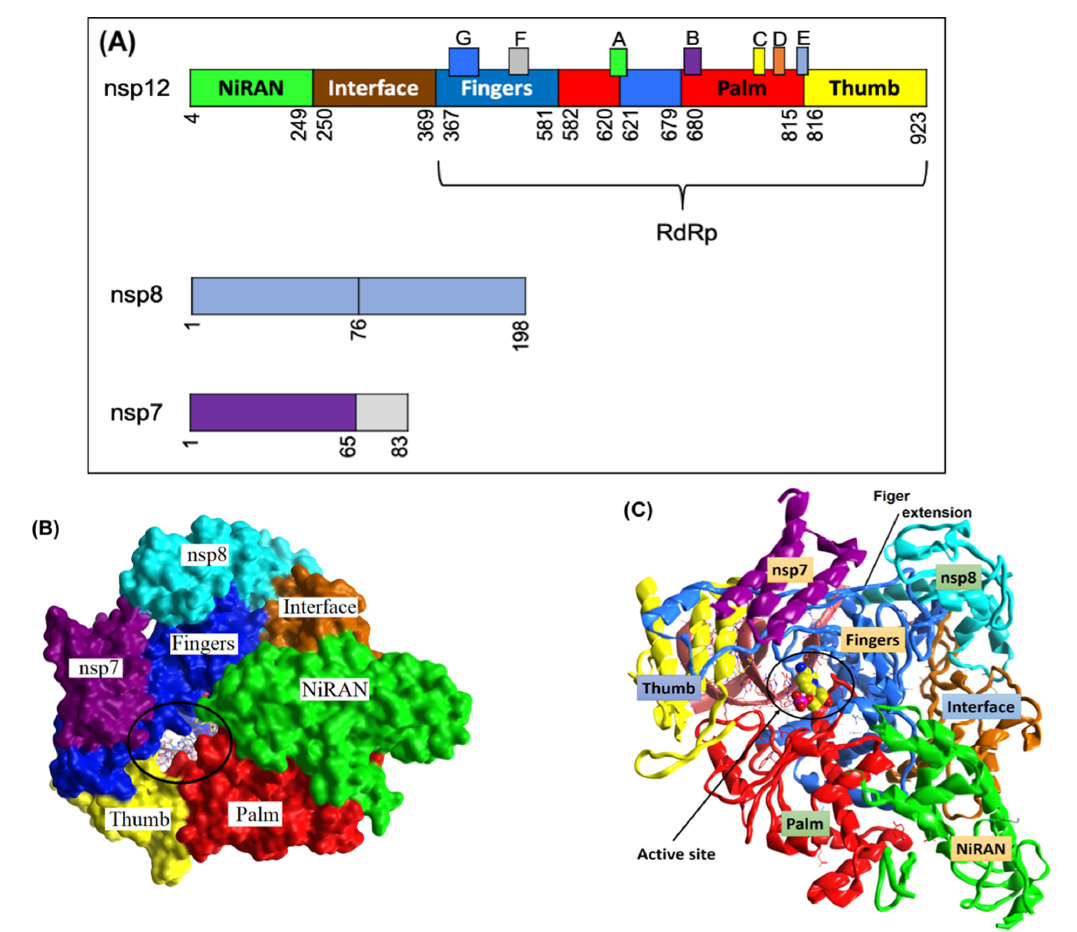
Figure 1. The SARS-CoV-2 core polymerase complex structure. ( A ) Schematic diagram of the SARS-CoV-2 RdRp complex. ( B ) Overall density map of the SARSCoV-2 nsp12-nsp7-nsp8 . ( C ) Overall atomic model of the nsp12–nsp7–nsp8 core complex of SARS-CoV-2 .